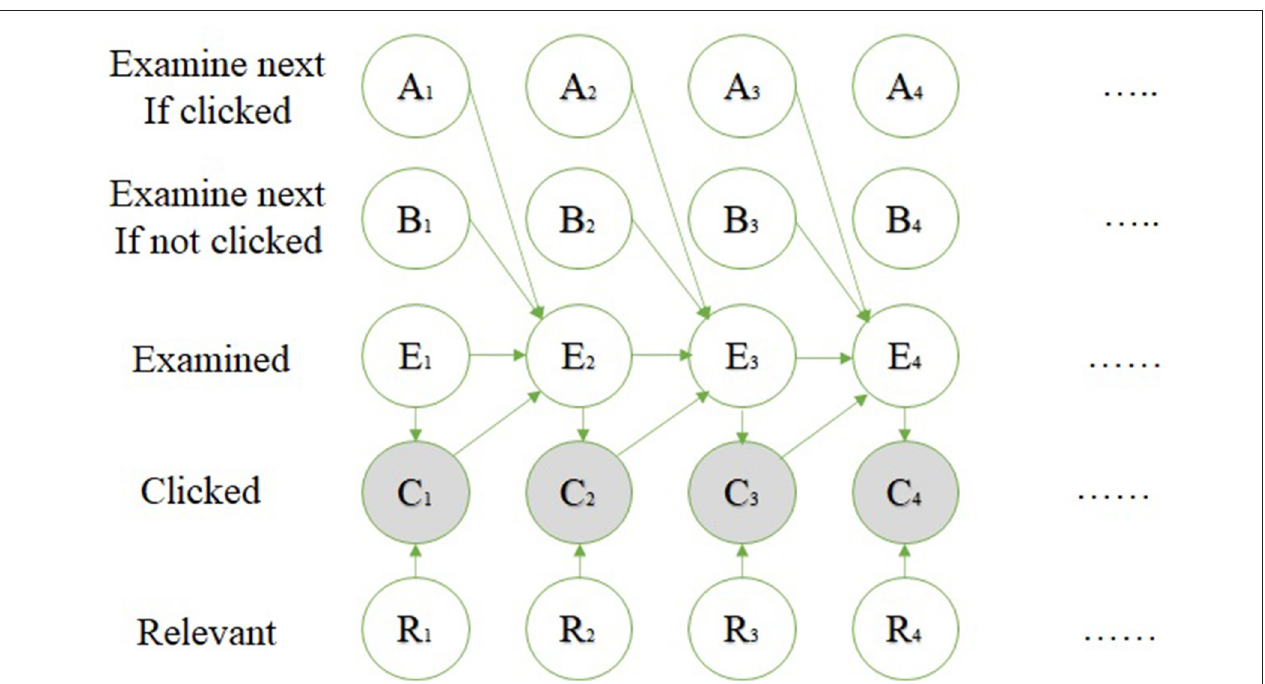
FIGURE 3 | Bayesian network